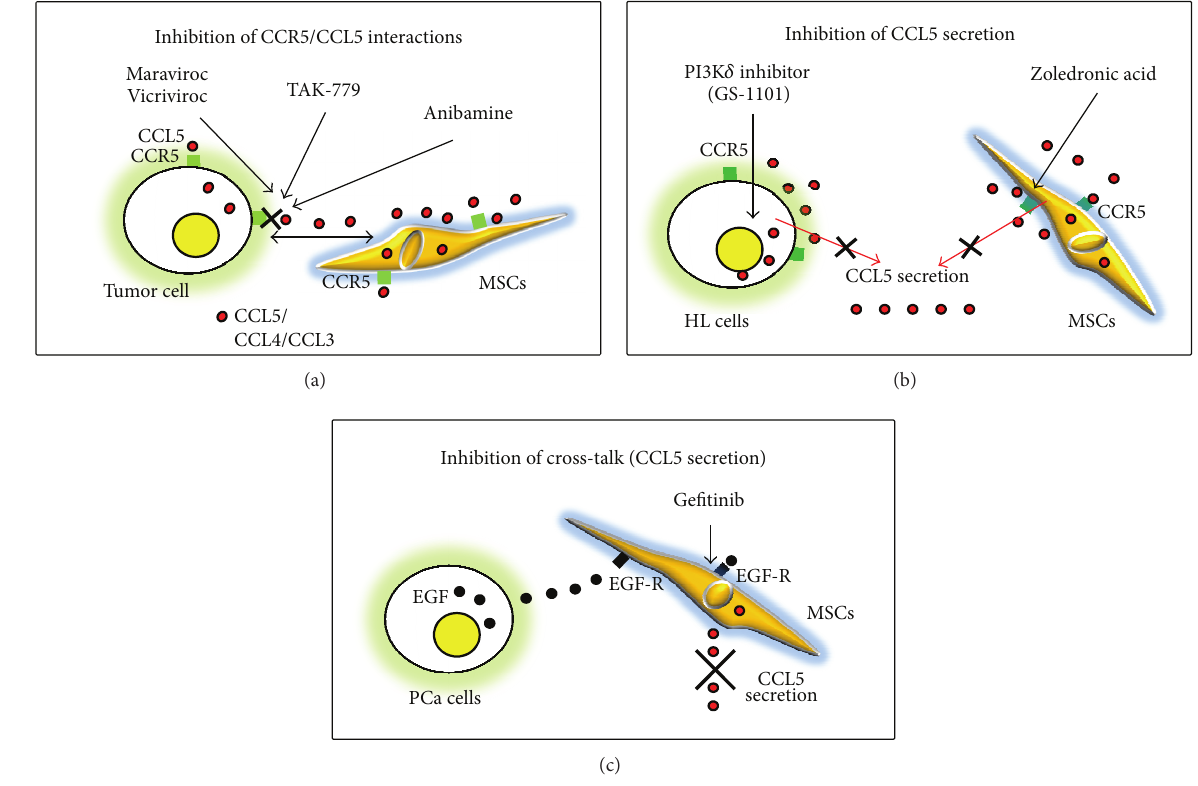
Figure 3: CCL5 and CCR5 as therapeutic targets in cancer. Different strategies proposed to disrupt the CCL5/CCR5 axis. (a) CCL5/CCL5 interaction may be inhibited by CCR5 antagonists. (b) CCL5 secretion by tumor cells or by MSCs of the tumor microenvironment may be decreased by treatment with chemotherapeutic agents. (c) The interactions between tumor cells and MSCs, mediated by EGF/EGFR pair, leading to increased CCL5 secretion by MSCs, may be inhibited by the EGFR-tyrosine kinase inhibitor